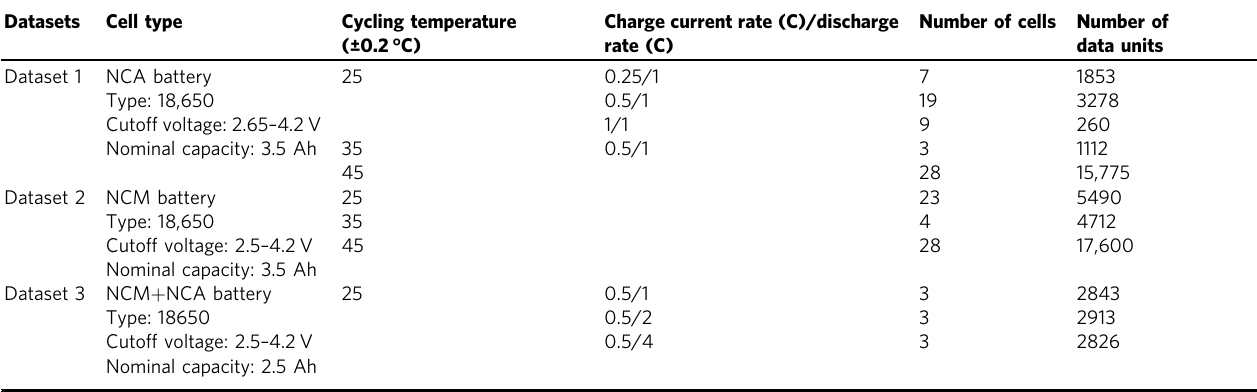
Table 1 Cycled batteries and cycling conditions for the dataset generation.